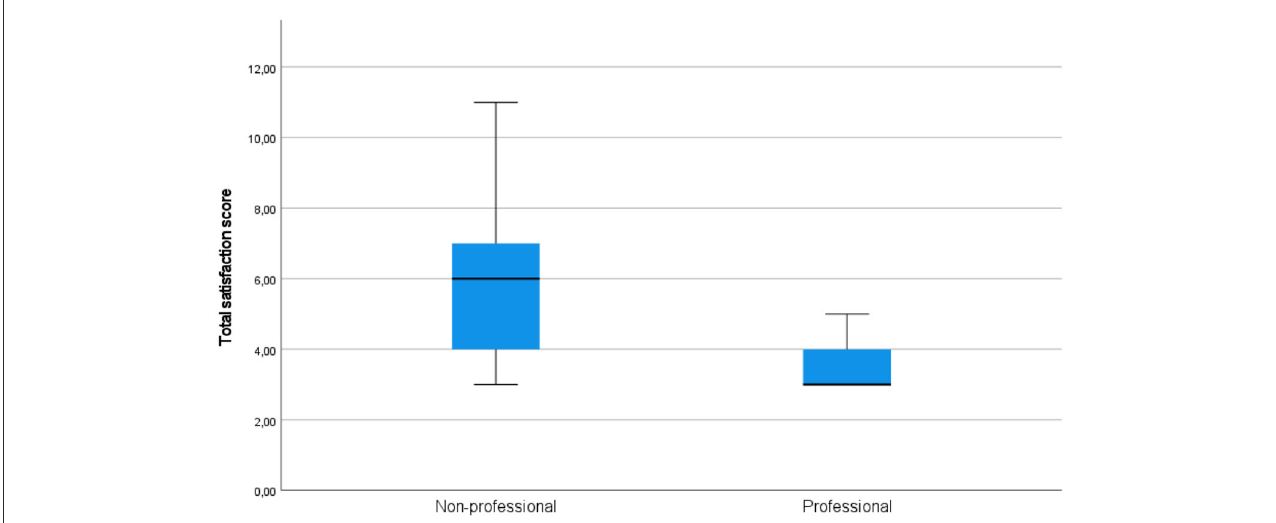
FIGURE5 Total satisfaction scores in the groups of professional and non-professional users of machine translation.